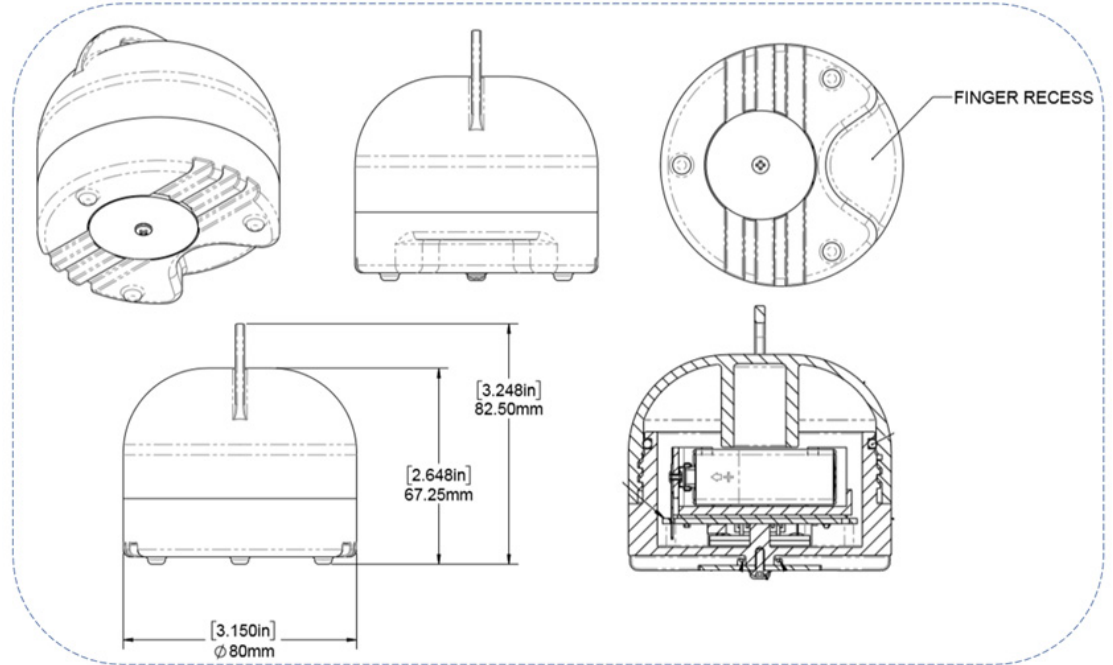
Figure 2. Drawing of the prototype assembly of the silver electrolytic device used in the field study.